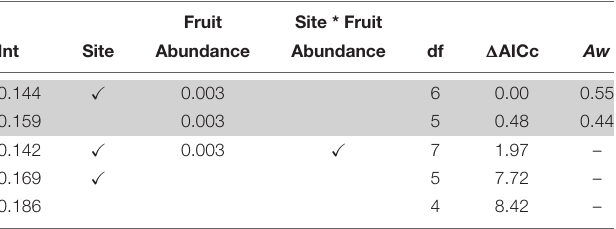
TABLE 3 | Factors influencing the proportional composition of seeds in elephant dungs. Fruit Site *